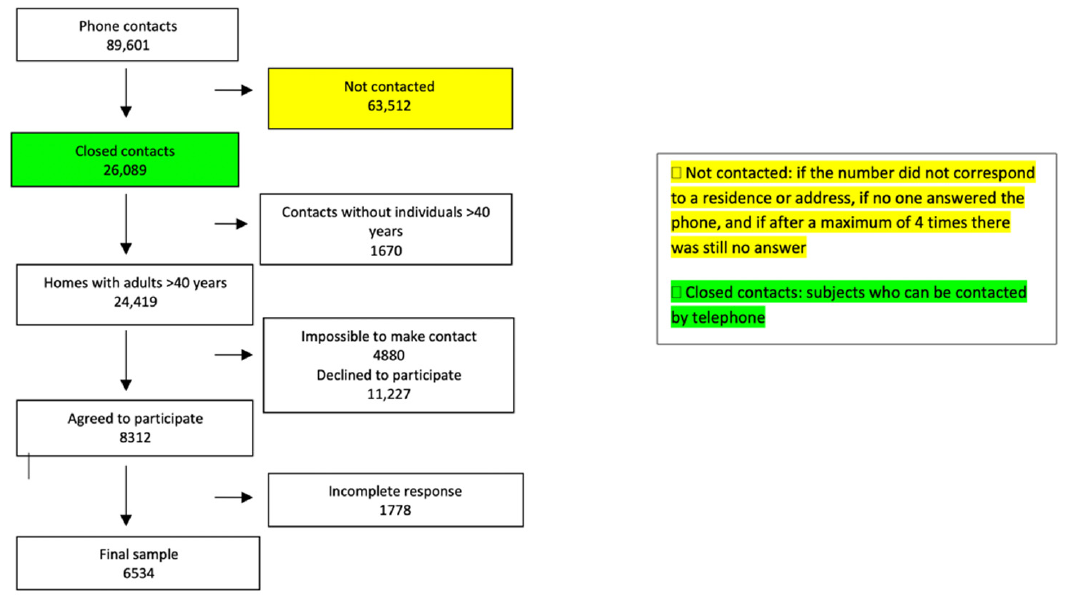
Figure 1. STROBE flowchart for the sample.